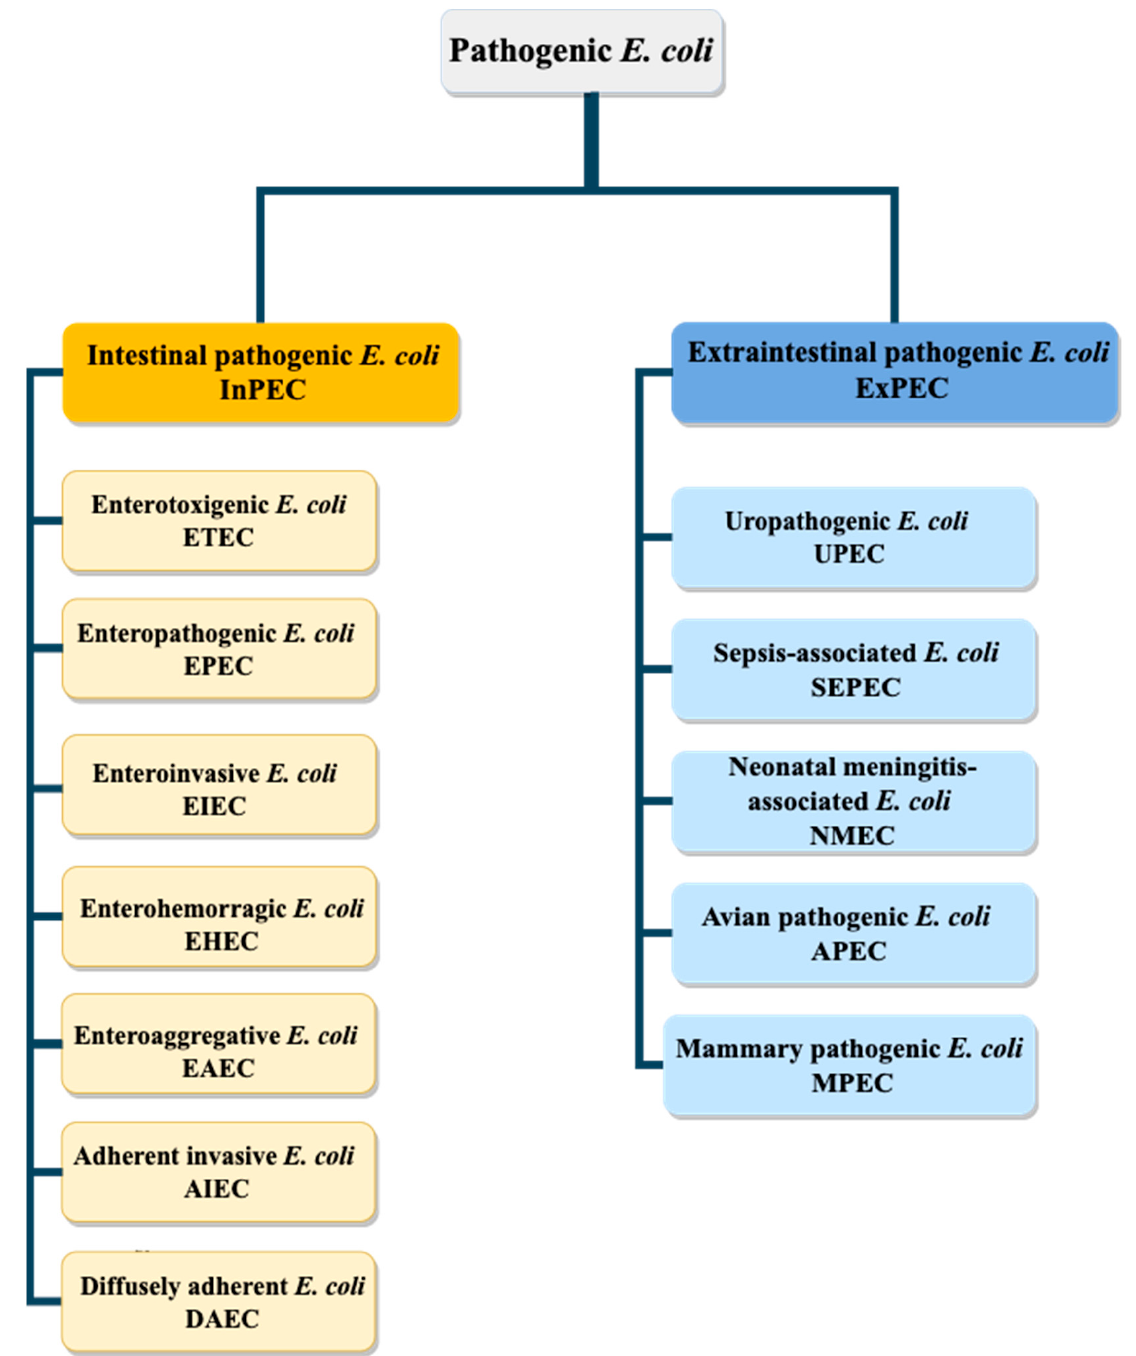
Figure 1. Diagram of pathogenic E. coli strains. E. coli pathogenic strains can be divided into two groups: extraintestinal pathogenic E. coli (ExPEC) and intraintestinal pathogenic E. coli (InPEC).